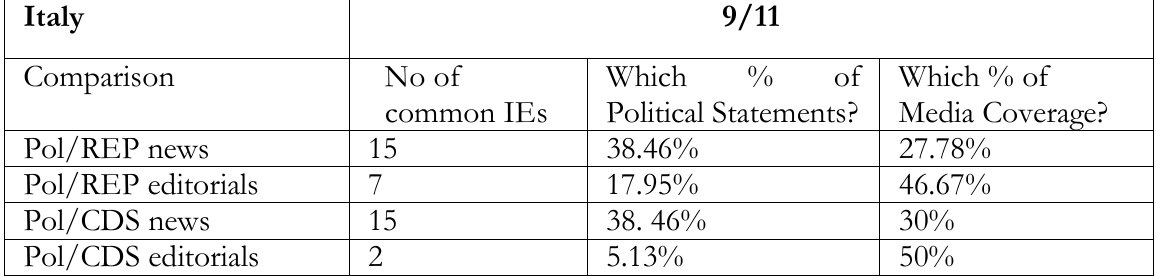
Table 7. Comparisons between political statements, first page news, and editorials in